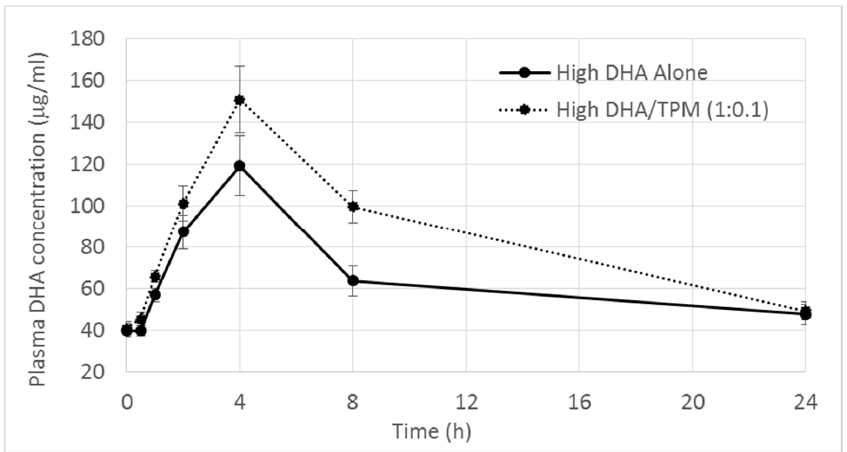
Figure 2. Mean omega-3/DHA plasma concentrations versus time following single oral doses of high omega-3 formulations with and without TPM (bars represent SEM).